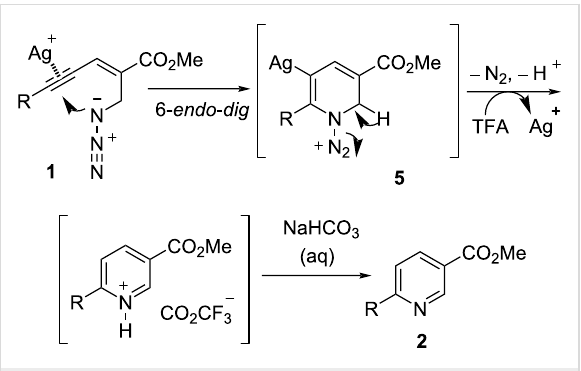
Scheme 2: The proposed mechanism of Ag-catalyzed